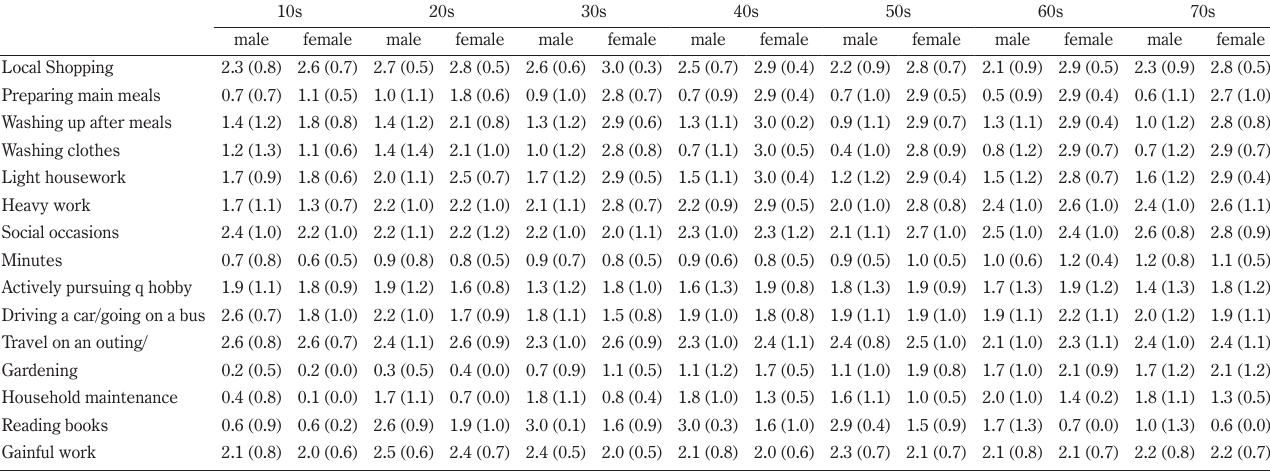
Table 5 Comparison of Frenchay Activities Index question items by sex for each age